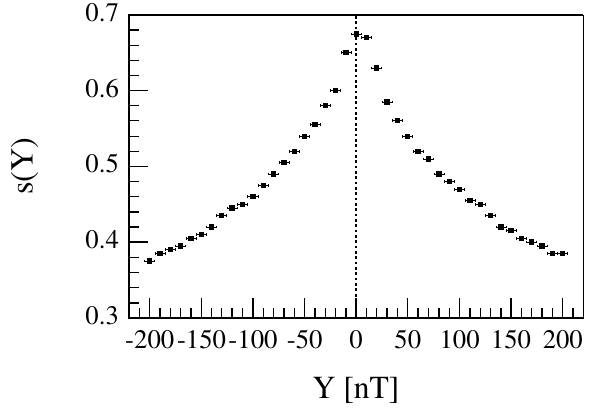
Fig. 7. Profile of the rank-ordered spectrum s ( Y ) for scaling exponents. Table 1. Scaling exponents s (0) versus Y range.